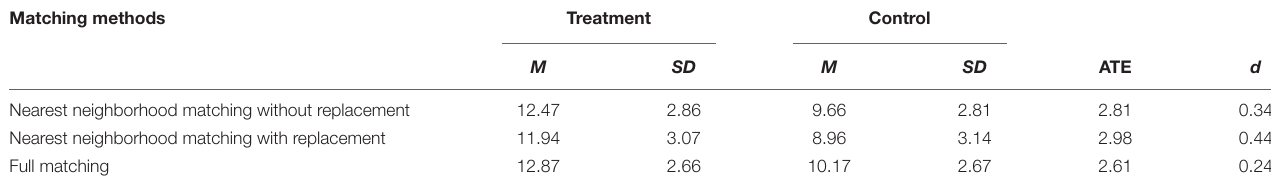
TABLE 7 | The average treatment effects (ATEs) of the extensive reading for different matching methods. Matching